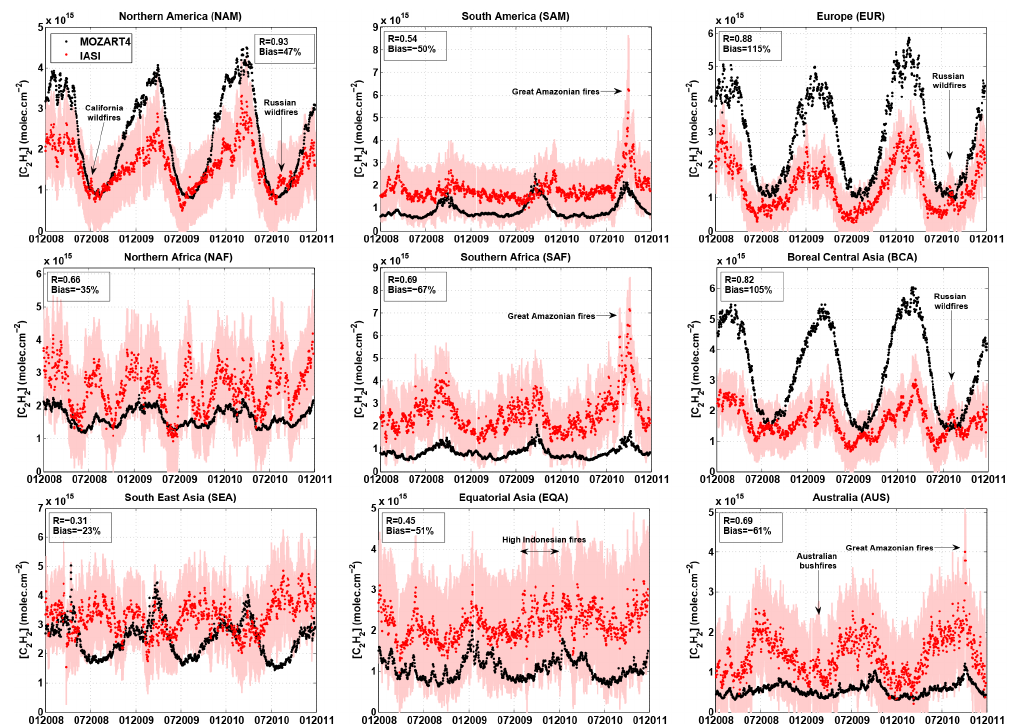
Figure 11. Evolution with time of the mean C 2 H 2 total column (inmoleccm − 2 ) over the zones defined in Fig. 6 as measured by IASI (red dots) with associated standard deviation (light red lines), and as simulated by MOZART-4 (black dots). Correlation coefficients ( R ) and biases (Bias) between IASI and MOZART-4 are given on each plot for daily